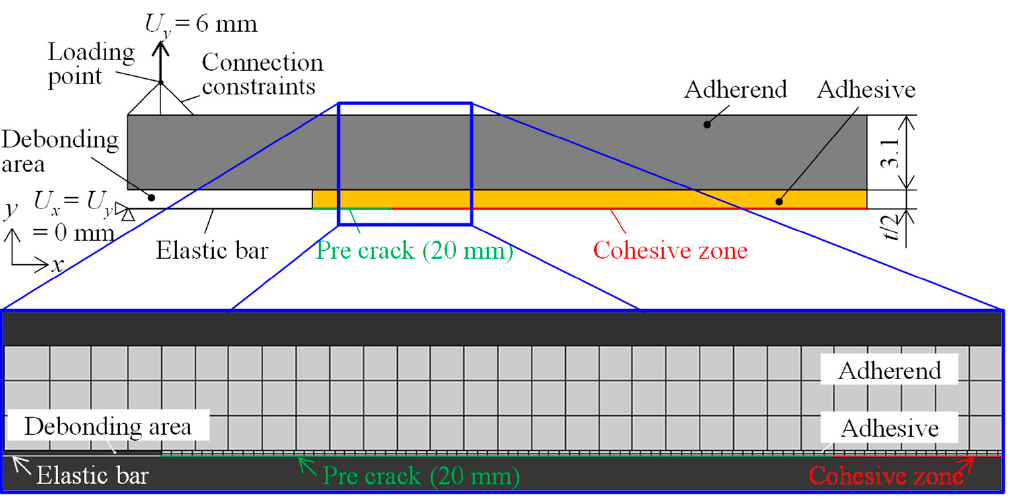
Figure 3. Finite element analysis model for a DCB specimen.